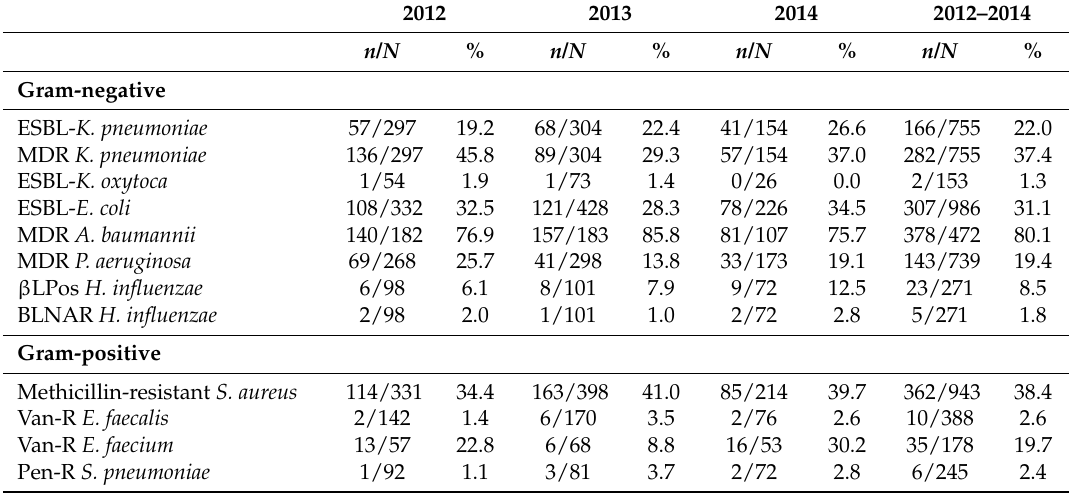
Table 2. Rates of Gram-positive and Gram-negative phenotypes collected from Italy between 2012 and